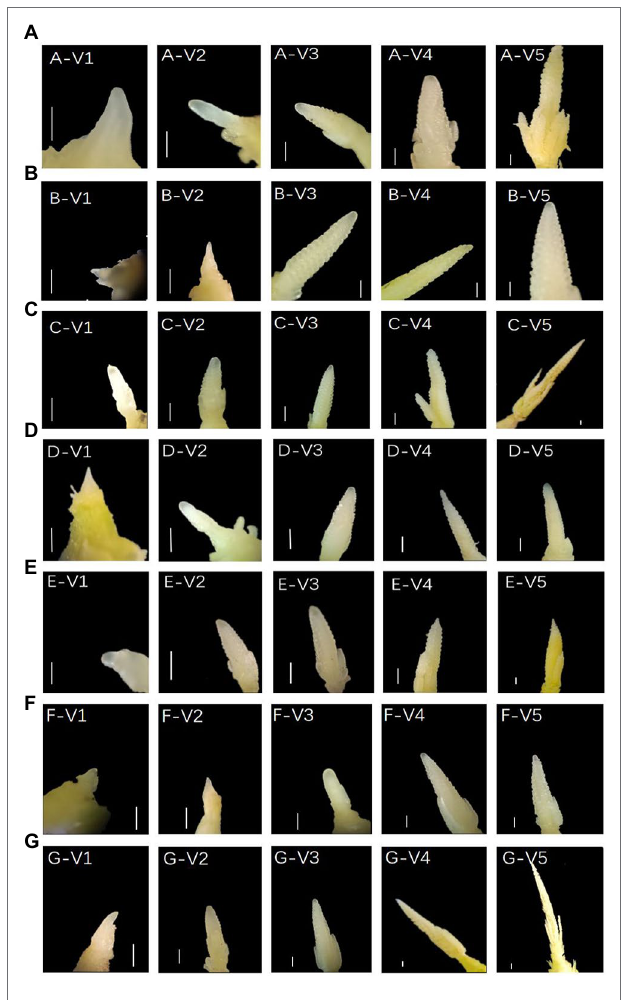
FIGURE 9 | Anatomical diagram of transgenic-positive plants and WT shoot apical meristems (SAMs). (A–G) represent WT, ZmTOC1-OE, ZmTOC1-KO, ZmPRR37-OE, ZmPRR37-KO, ZmPRR95-OE, and ZmPRR95-KO, respectively. V1, V2, V3, V4, and V5 represent days 23, 27, 30, 33, and 36 post-emergence, respectively. Scale bars (V1,V2,V3, V4,V5) = 500 μ